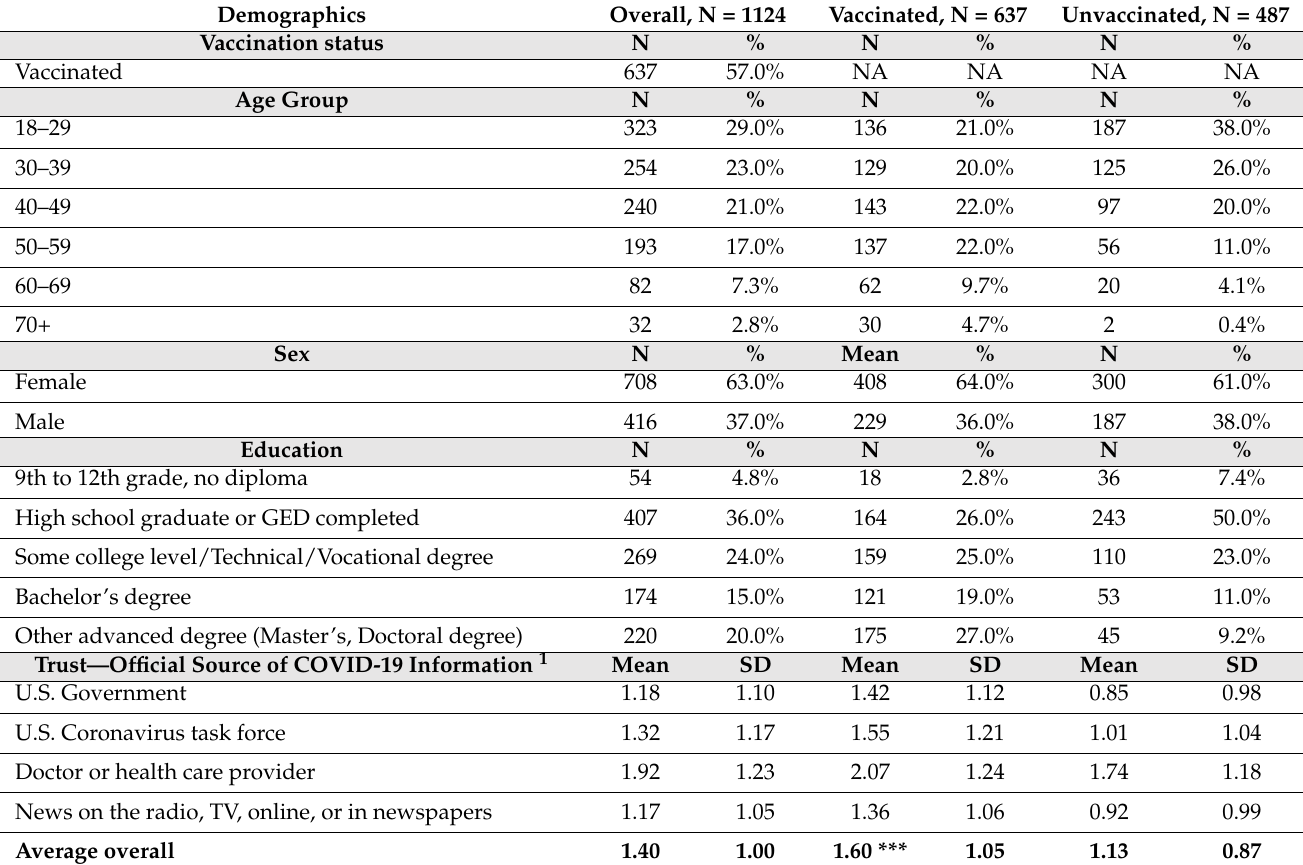
Table 1. Summary statistics of responses to RADx-UP survey broken down by vaccination